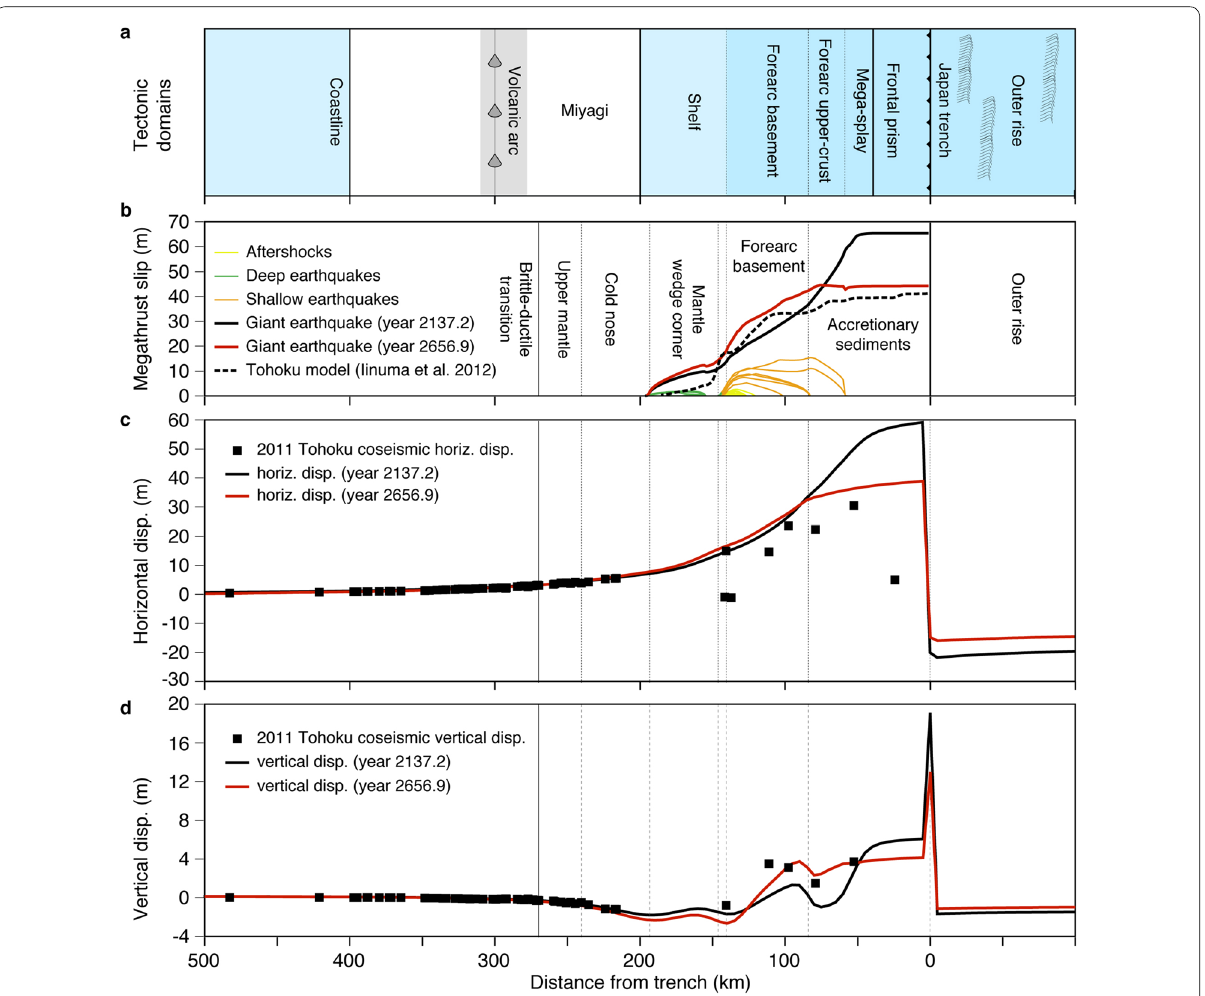
Fig. 6 Deformation induced by giant ruptures. a Tectonic domains along a 600-km section of profile A–A’. b Slip distribution of simulated earthquakes and kinematic model of the 2011 Mw 9.1 Tohoku earthquake (Iinuma 2012). c Surface horizontal displacements induced by two = simulated giant ruptures 2137.2 (black profile) and 2656.9 (red profile) years after the start of the simulation and geodetic coseismic displacements within 50 km of profile A–A’ in Miyagi for the Tohoku mega-quake. The on-land measurements originate from GEONET (Sagiya et al. 2000; Ozawa et al. 2011). The offshore measurements include GPS-acoustic and ocean bottom pressure gauges data summarized by Iinuma (2012). d Same as above panel, but for the vertical